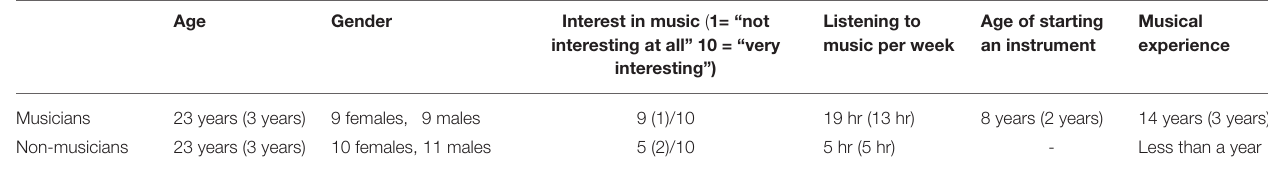
TABLE 1 | Means and standard deviations (in parentheses), for musicians and non-musicians based on a questionnaire. Age